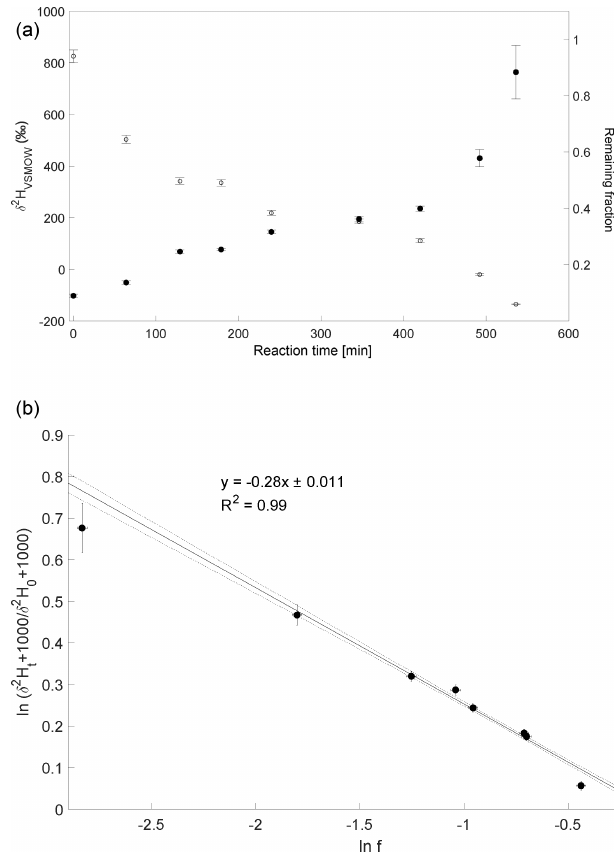
Figure 3. Reaction of CH 3 Cl and Cl. Initial mixing ratio of CH 3 Cl was ∼ 10ppmv. More than 90% of the CH 3 Cl was degraded within 7 to 8h. (a) Measured δ 2 H values (filled circles) of CH 3 Cl versus residual fraction (open diamonds) CH 3 Cl. Error bars of δ 2 H val- ues of CH 3 Cl indicate the standard deviation (SD) of the mean of three replicate measurements. Some error bars lie within the sym- bol. (b) Rayleigh plot (Eq. 3). Data are expressed as the mean ± standard error of the mean, n = 3. Error bars were calculated by error propagation including uncertainties in δ 2 H values of CH 3 Cl. Dashed lines represent 95% confidence intervals of the linear re- gressions (bold line).